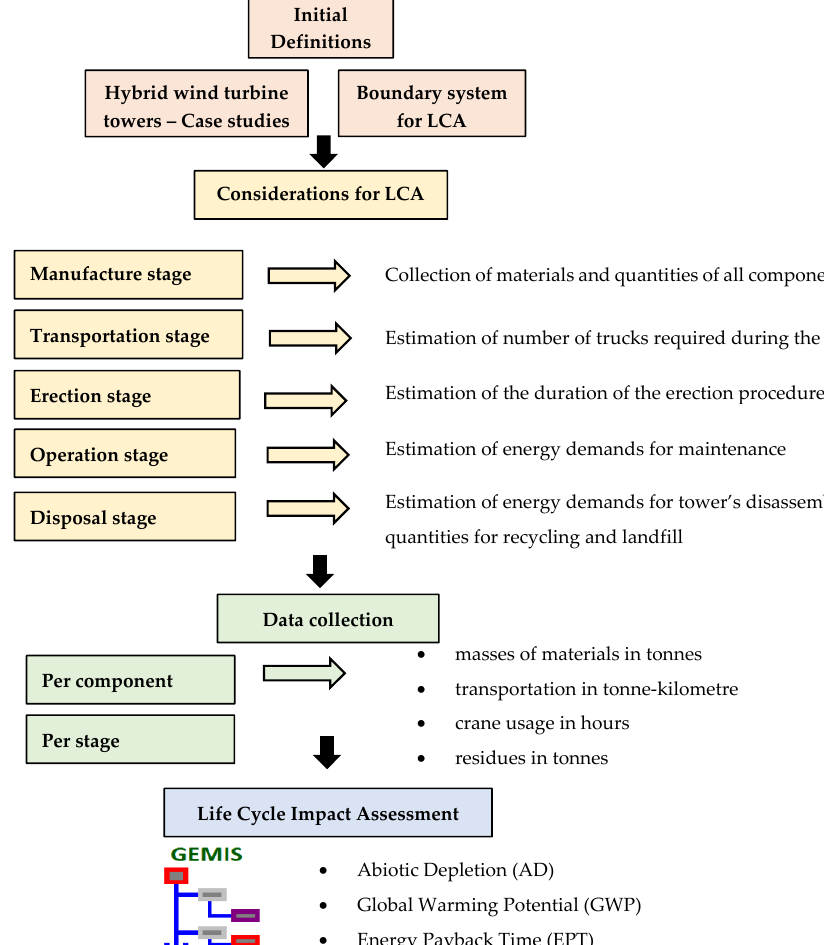
Figure 1. Flowchart of adopted methodology.